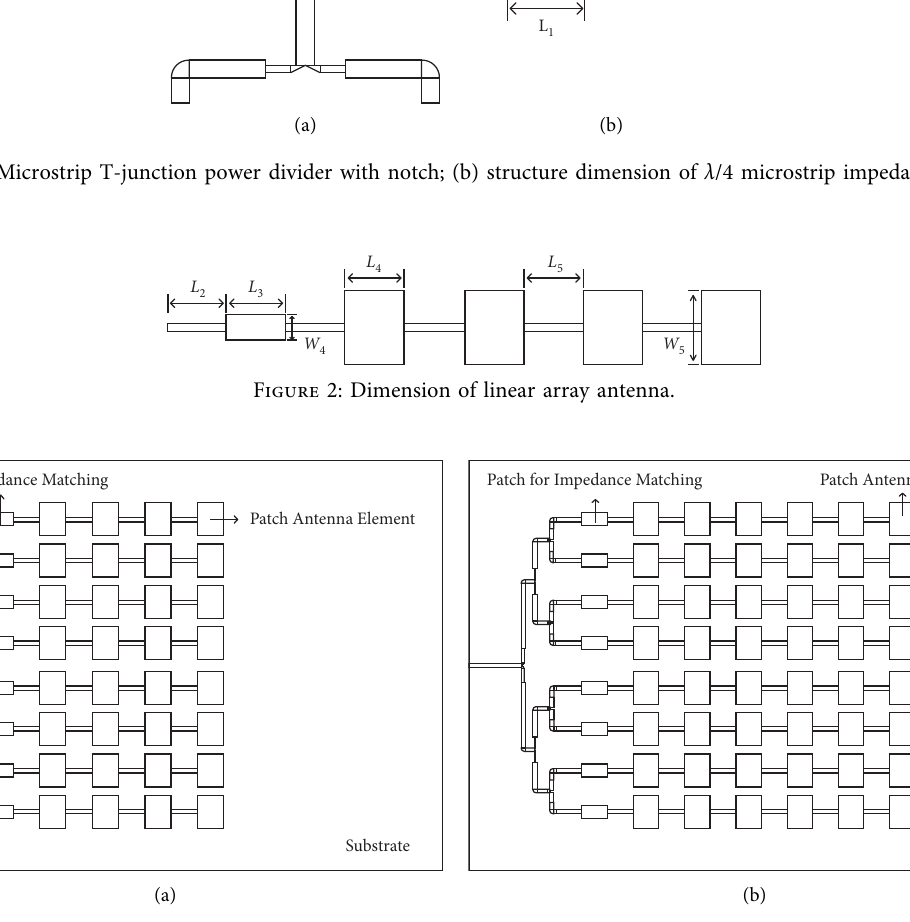
Figure 3: Designed 8 × 4 (a) and 8 × 8 (b) broadside uniform array antenna models in HFSS.